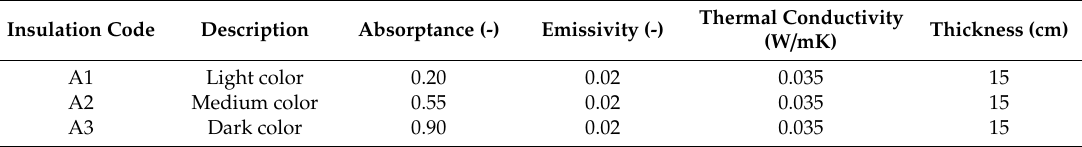
Table 1. Thermo-physical properties for the analyzed insulation.